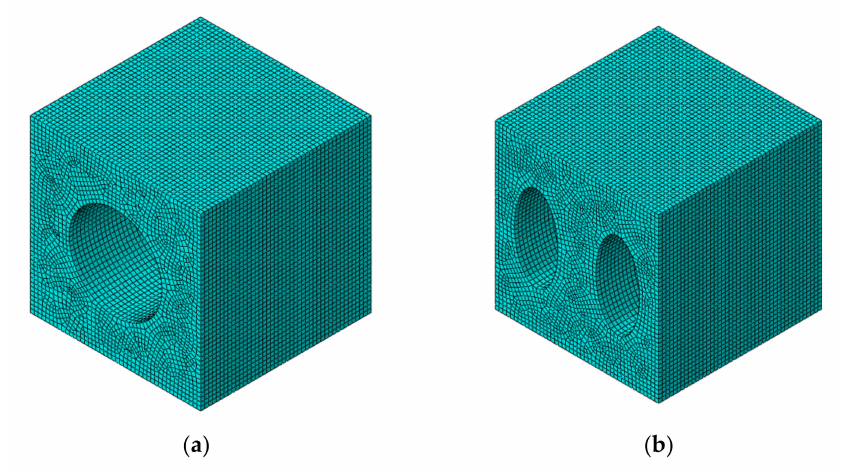
Figure 10. The shape of unit cell after meshing. ( a ) Circular pores. ( b ) Elliptical pores. In case of elliptical pores, the length of cubic was 433.13 µ m and the diameters of holes were 120.0 µ m and 233.13 µ m. The mesh style was as same as in the case of circular pores, but the size was 10 µ m and the number of mesh was over 77,000. It is shown in Figure 10. Tensile strain and shear strain were loaded with boundary condition, and 0.1% of strain was applied. The tensile strain, shear strain by each direction, was applied in each step. Step 1 was for tensile strain of X direction, step 2 was for tensile strain of Y direction, step 3 was for tensile strain of Z direction, step 4 was for shear strain of XY direction, step 5 was for shear strain of XZ direction, and step 6 was for shear strain of YZ